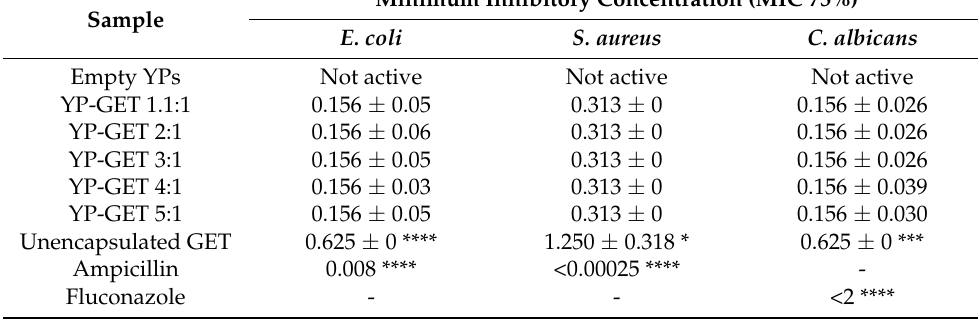
Table 2. In vitro antimicrobial activity of negative YP control, YP-GET, unencapsulated GET, and positive drug controls (ampicillin and fluconazole) on two bacteria and one fungal model organism. The MIC results (mg/mL) represent the average of three biological replicate experiments with three technical replicates for each experiment. Statistically significant results were obtained between YP- GET 1.1:1 and unencapsulated GET for the tested microbes (* p < 0.1, *** p < 0.001, **** p < 0.0001) and between YP GET (all ratios) and ampicillin or